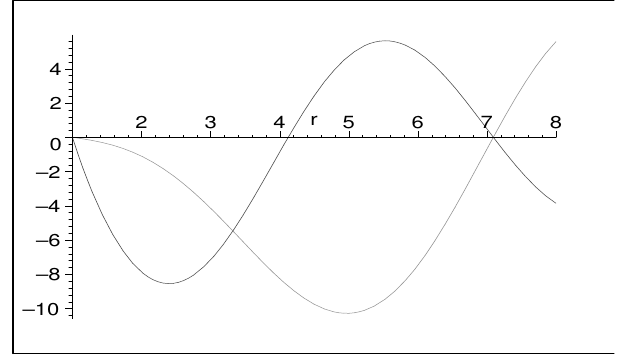
Figure 2. Plots of f 1 and f 4 for λ ≈ 1 . 0699. In this case both the functions vanish at r = R m = 1 and r = R M ≈ 7 .